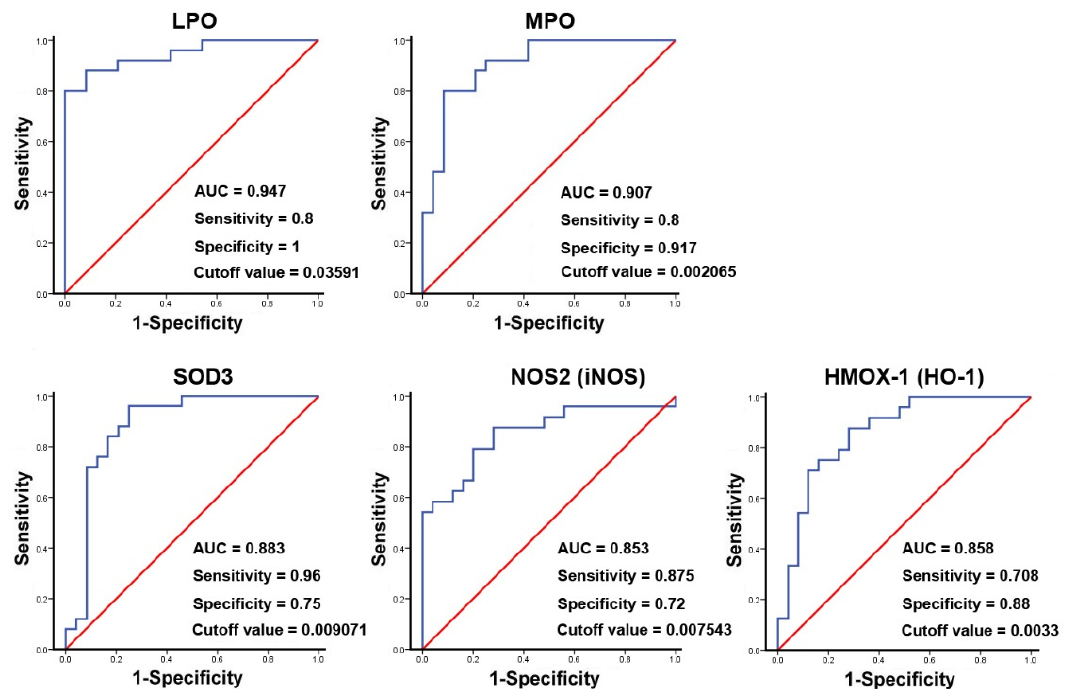
Figure 6. ROC curve analysis of potential oxidative stress biomarkers used to predict the development of CRSwNP. The markedly changed genes, including LPO, MPO, SOD3, NOS2 (iNOS), and HMOX-1 (HO-1), in the NPs of 25 patients with CRSwNP were analyzed using an ROC curve analysis. The p -values for the genes were 8.32 × 10 − 8 , 1.06 × 10 − 6 , 4.22 × 10 − 6 , 2.24 × 10 − 5 , and 1.71 × 10 − 5 , respectively.